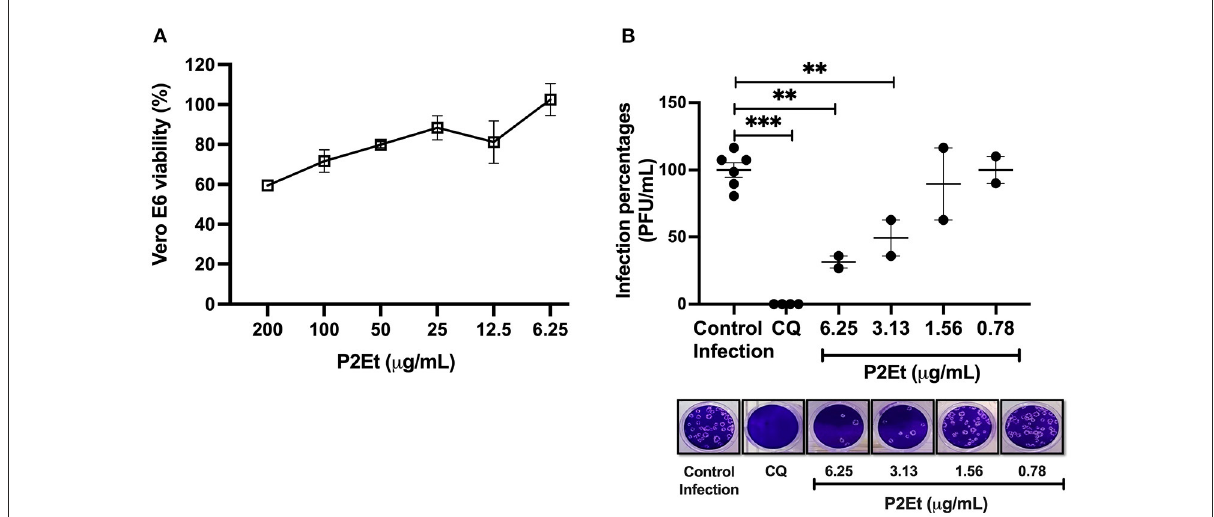
FIGURE4 P2Et exhibit antiviral activity against SARS-CoV-2 with a concentration-depending effect. (A) Vero E6 viability after 48h of P2Et treatment was evaluated by MTT assay (6.25- − 200 µ g/mL). Data were presented as Mean ± SEM. The viability percentages of the treated cell were calculated based on untreated control. Two independent experiments with three replicates each were performed ( n = 6). (B) The SARS-CoV-2 titer (PFU/mL) was reduced in Vero E6 supernatants after pre-post treatment with P2Et ( n = 2). CQ (100 µ M) was used as a positive control of viral inhibition. Data are represented as the mean ± SEM. The p values were calculated using a Mann-Whitney test, ** p < 0.01, *** p < 0.001. Representative plaques of each treatment condition are